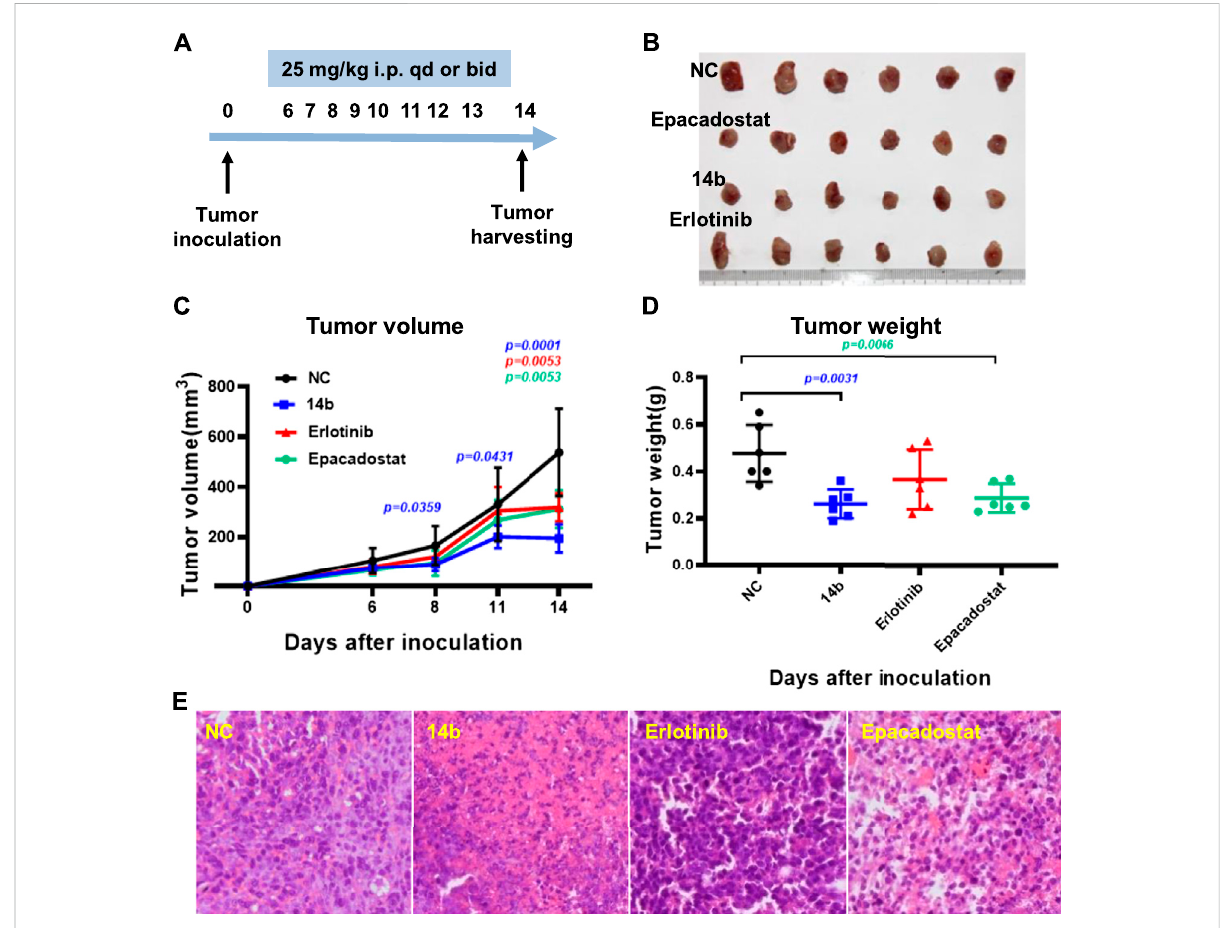
FIGURE 8 Effects of compound 14b on 4T1 allograft tumor growth in BALB/c mice. (A) Experimental procedure of the murine 4T1 breast model. (B) Growth morphology for the 4T1 tumors from the BALB/c mice after treatment with vehicle, compound 14b , Erlotinib and Epacadostat ( n = 10, 9, 10 and 10, respectively). (C) Tumor volumes formed by 4T1 cells 14 days after inoculation ( n = 6). (D) Tumor weight of 4T1 allograft were presented ( n = 6). (E) Compound 14b -induced extensive necrosis within tumors detected by Hematoxylin and Eosin (H&E)